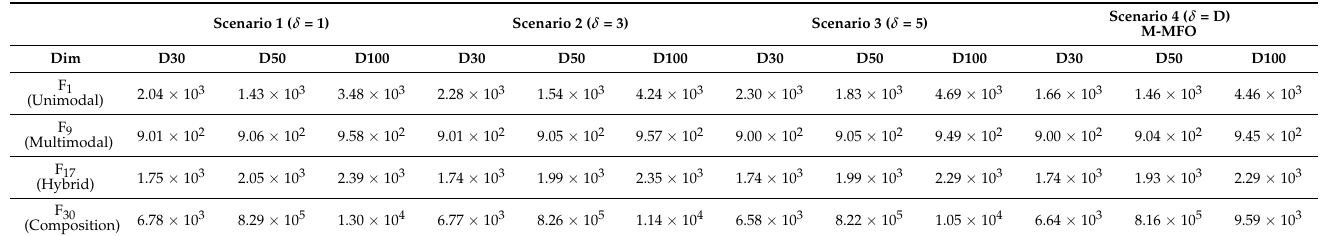
Table 7. Results of sensitivity analysis on the guiding archive maturity size.